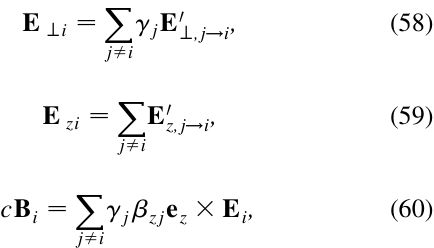
FIG. 13. (Color) Comparison between the reduced 3D-PPI model in the paraxial approximation (solid line) and the electrostatic PIC (dashed line) for the case of a large energy spread beam with an exponential energy profile. Input parameters: Charge Q (cid:1) 5 nC , (cid:1) 10 (cid:4) m , divergence x 0 (cid:1) 2 mrad , typical distance between macro- T (cid:1) 4 MeV , radius a (cid:1) 6 (cid:4) m , half-length a temperature k B 3 max (cid:1) 422 nm and cutoff radius r (cid:1) 100 nm . Evolution of (a) transverse radius a and transverse RMS momentum spread particles n (cid:6) 1 = 3 0 0 , (b) longitudinal half-length a and longitudinal RMS momentum spread (cid:1) u as a function of propagation distance s is shown. (cid:1) u x z 3